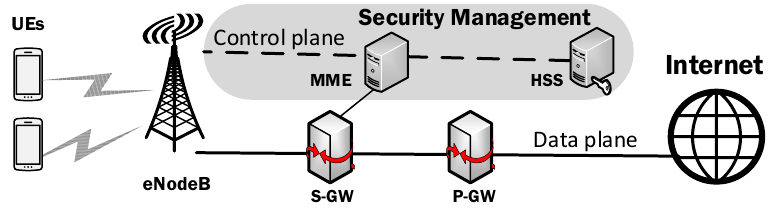
Figure 1. Security management based on the vertical model distributed servers such as Mobility Management Entity (MME) and Home Subscriber Server (HSS) in LTE networks.